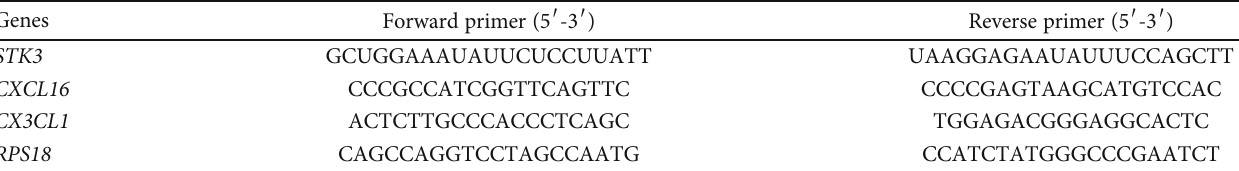
Table 1: The oligonucleotide sequence of primers used in this experiment. Genes Forward primer (5 ′ -3 ′